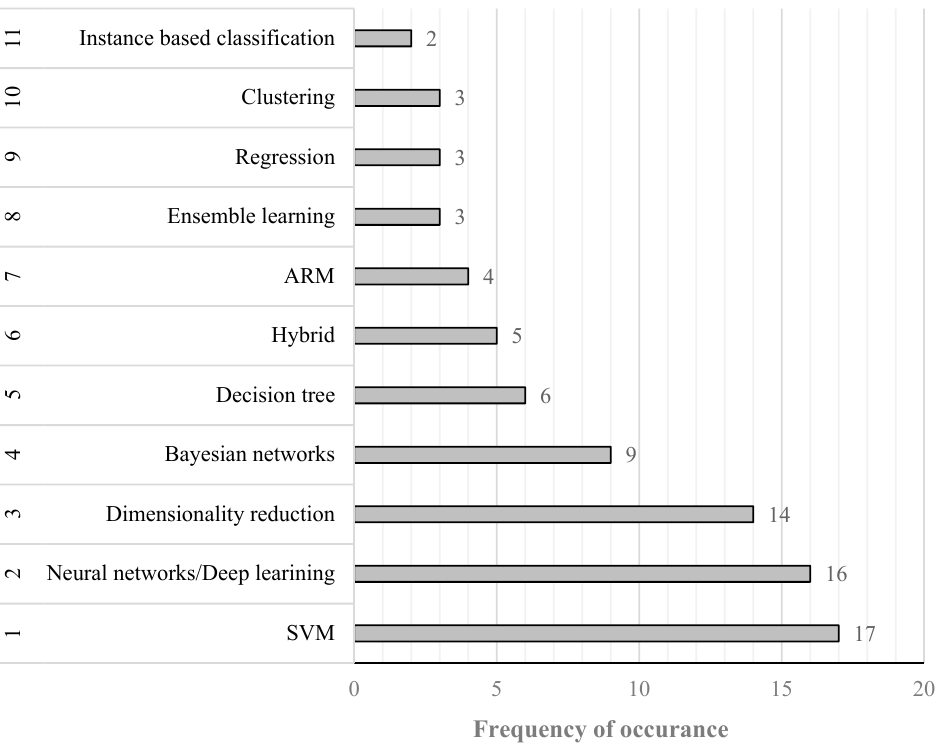
Figure 5. The extent of data-driven techniques used for FDD of HVAC, based on the reviewed papers.